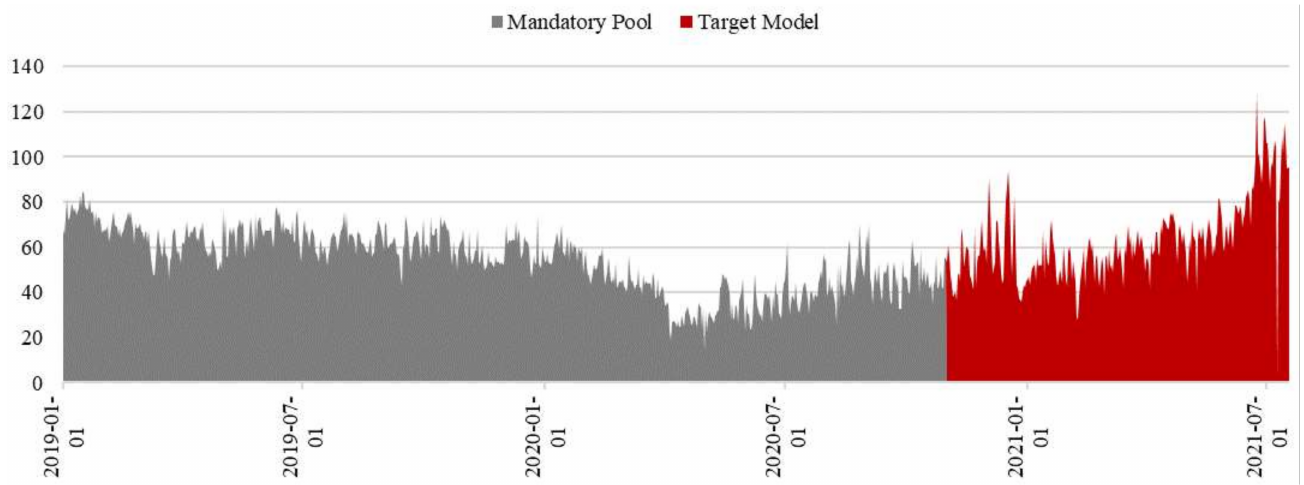
Figure 12. Daily Average Market Clearing Price in Greece ( € /MWh), (2018–July 2021), Source: Hellenic Energy Exchange and Authors’ estimations.